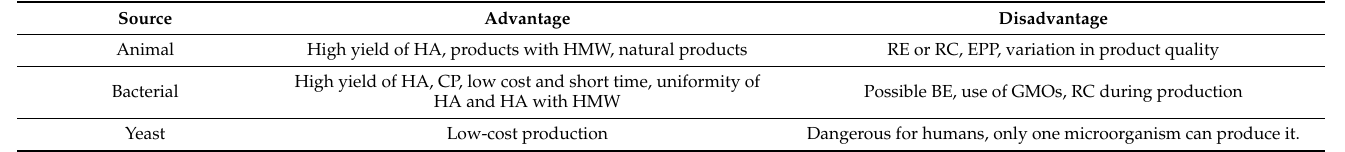
Table 1. Advantages and disadvantages of different HA extraction sources [7].